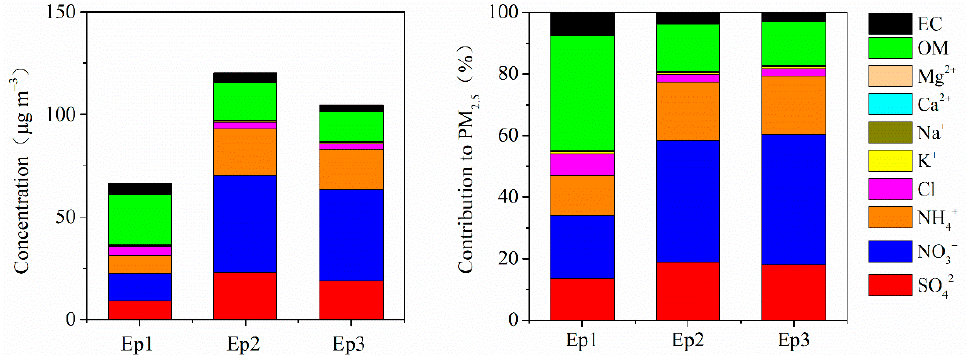
Figure 4. Concentrations and contributions of chemical PM 2.5 components during